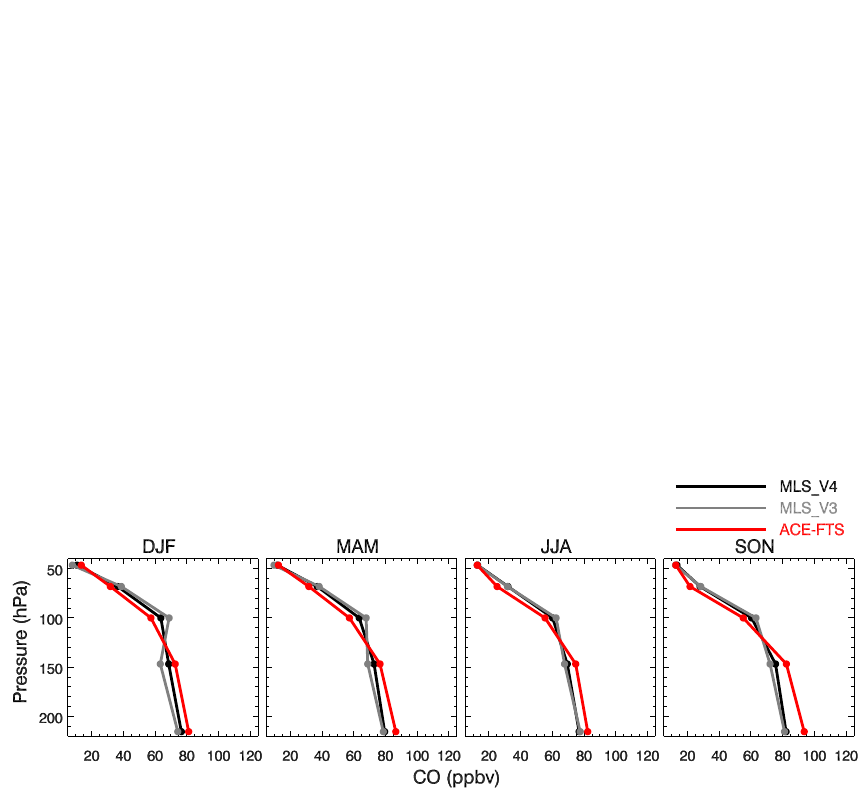
Figure A2. Climatological (8-year) seasonal mean vertical profile of CO mixing ratio from MLS Version 4 CO data (black line), MLS Version 3 CO data (gray line) and ACE-FTS CO data with MLS AKs applied (red line) over the tropics (30 ◦ S–30 ◦